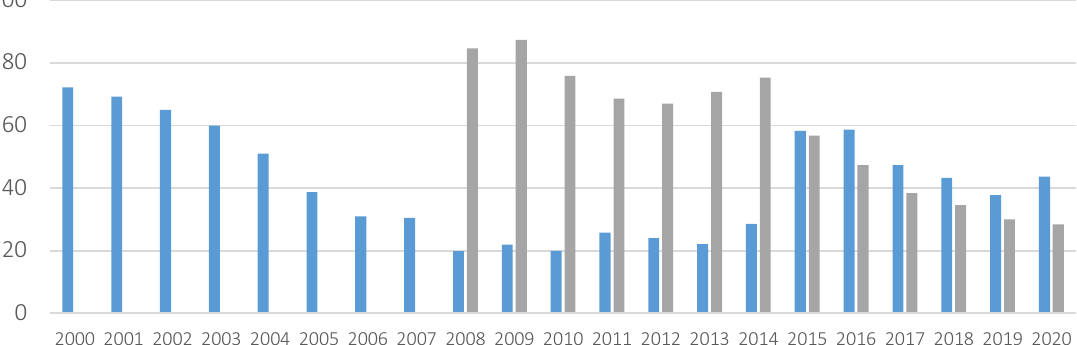
Table 4. The top 10 richest and poorest countries in Europe in 2020 No.